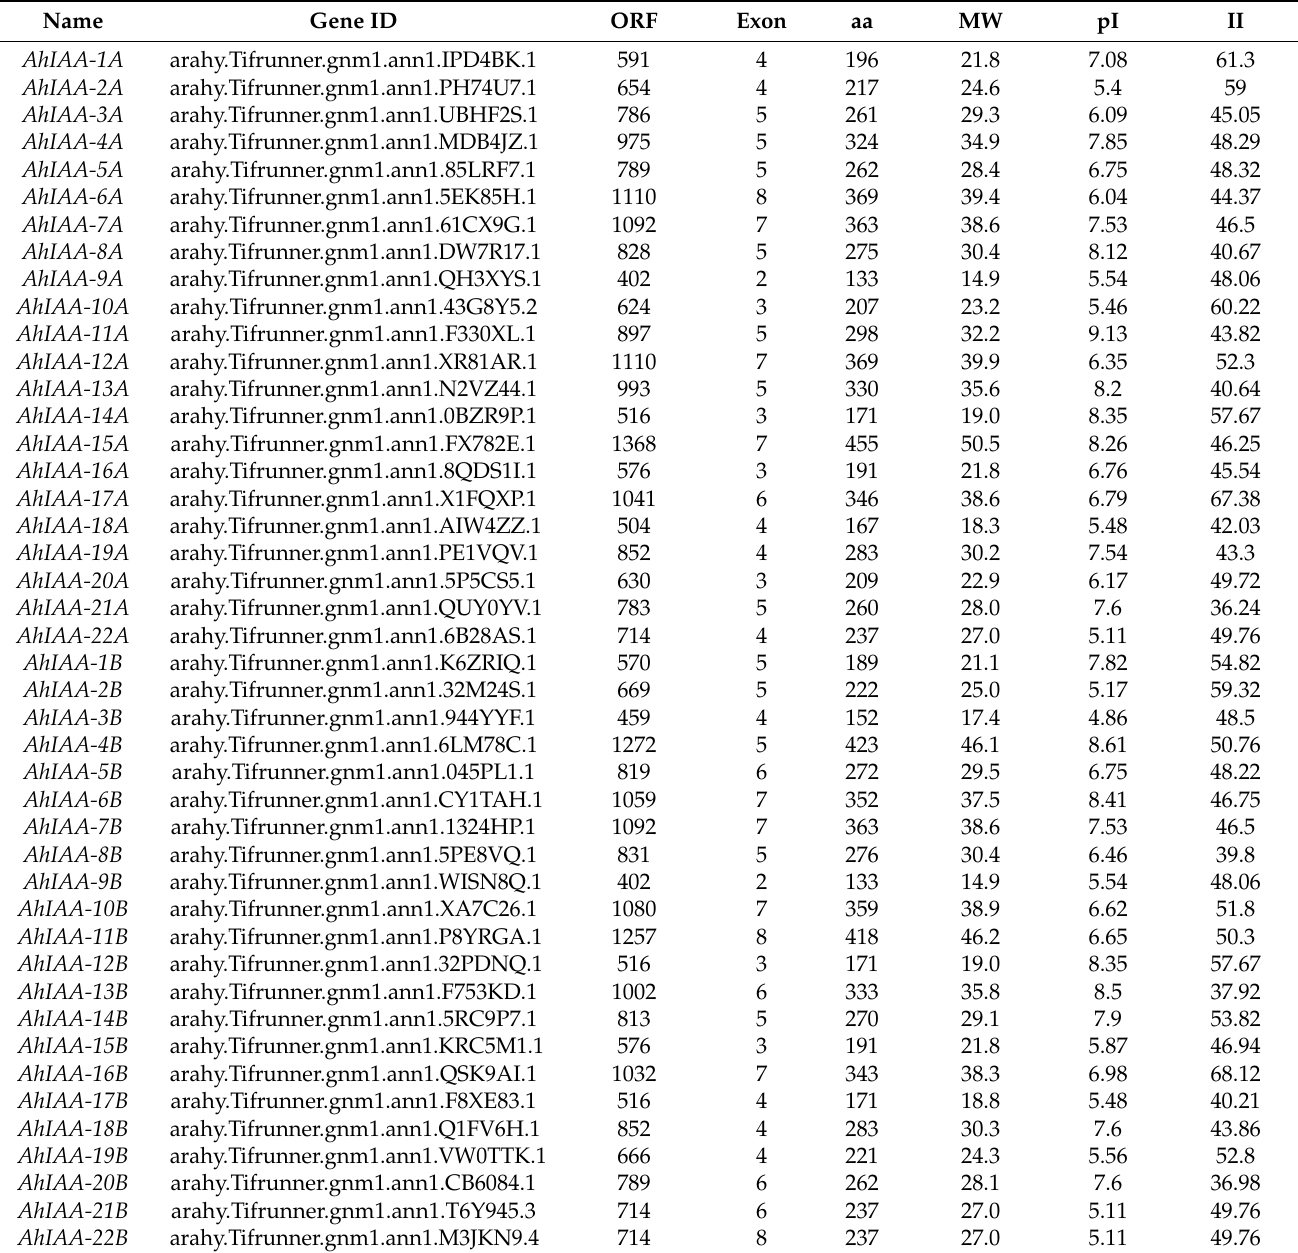
Table 1. Features of AhIAA genes identified in